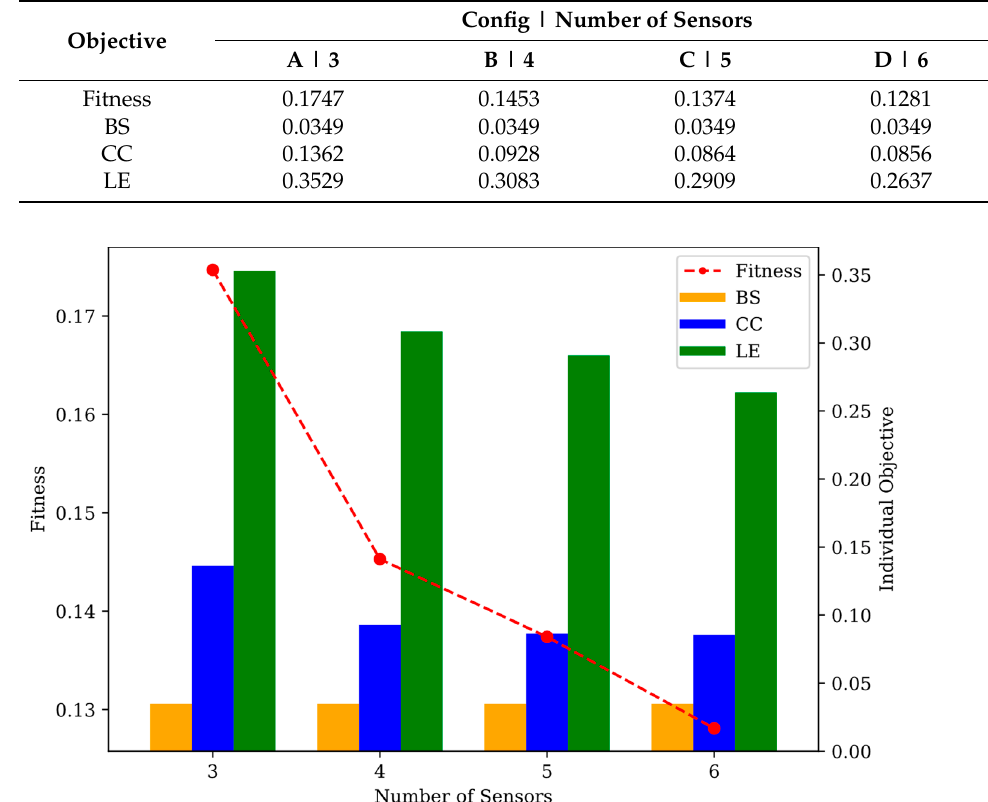
Figure 9. Sensor configuration for NET-B ( a ) Config-A, ( b ) Config-B, ( c ) Config-C, and ( d ) Config-D. Table 5. Performance comparison for NET-B. Table 5. Performance comparison for NET-B.